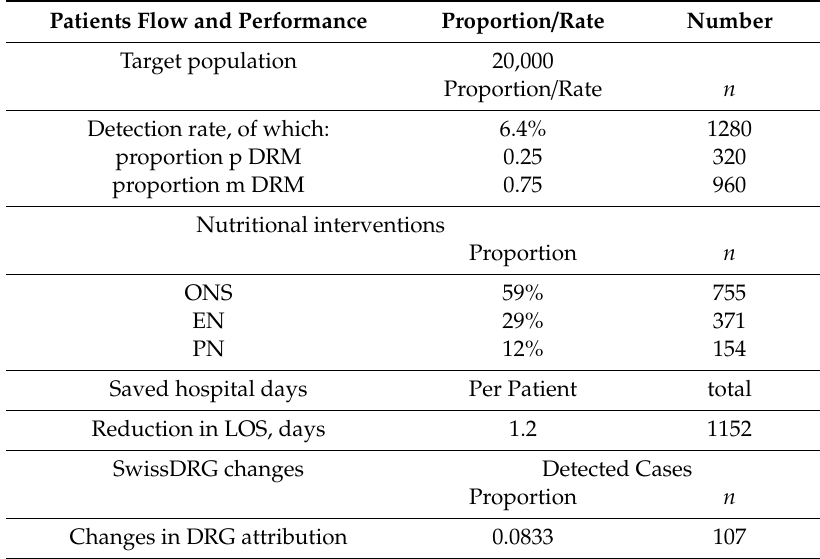
Table A1. Patient flow and resource use in connection with ND.